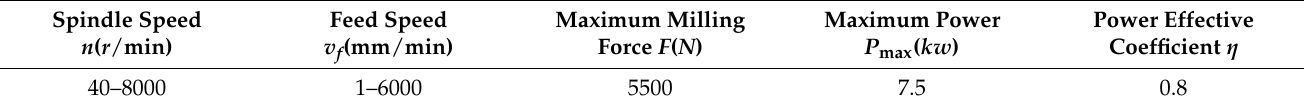
Table 1. Specifications of CNC machining center.